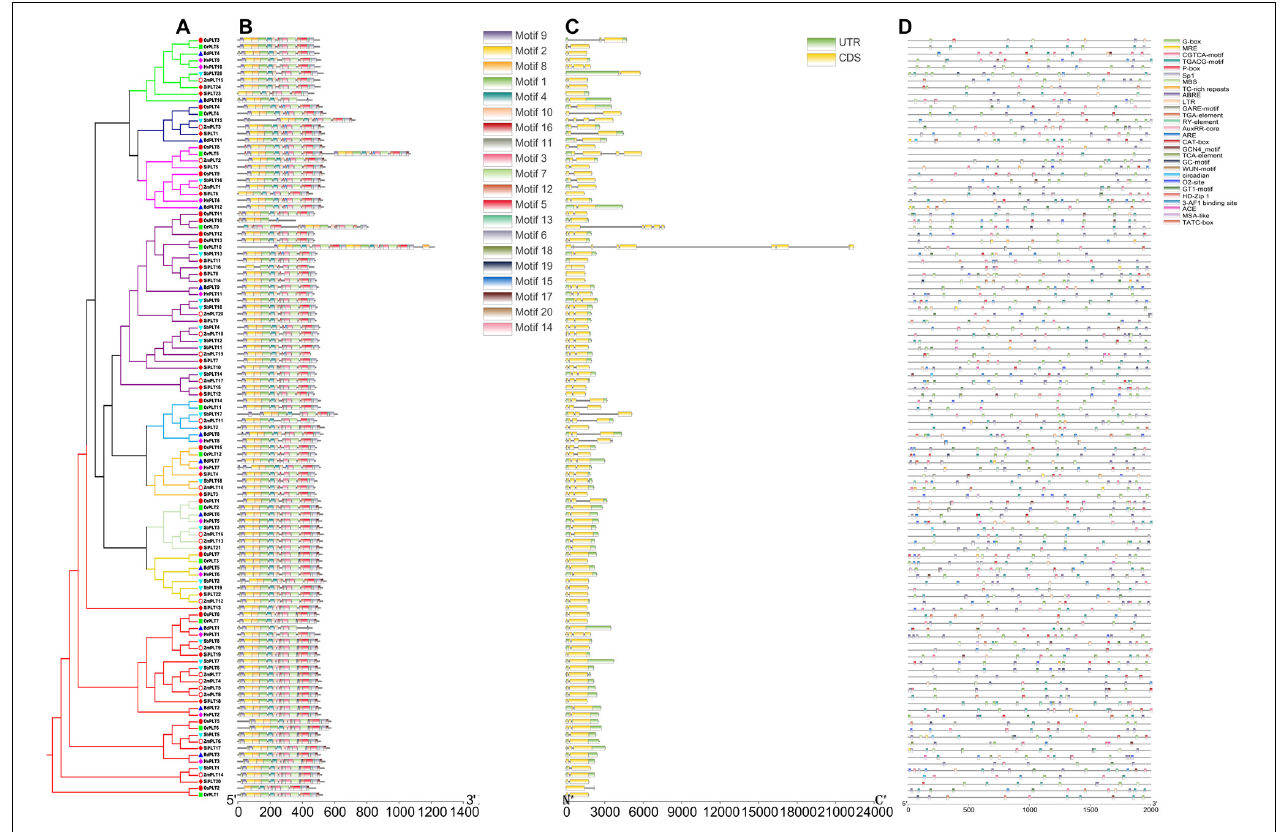
FIGURE 5 | The phylogenetic tree (A) , conserved motif (B) , exon/intron compositions (C) and cis-elements (D) in the upstream promoters of the PLT genes in these seven species. The different colors of the branches represent different orthogroups and the different shapes of the markers mean different species in the phylogeny tree. The relative lengths of genes and proteins are shown by the width of the gray bars. The different motifs/cis-elements are distinguished by different colored boxes. The exons and introns are displayed by yellow boxes and gray lines,